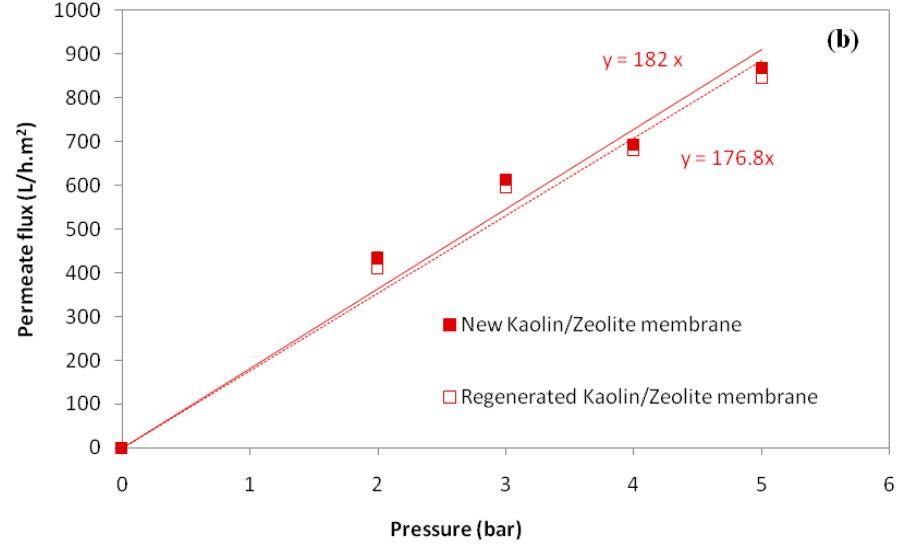
Figure 10. Water permeate flux versus transmembrane pressure for the new and regenerated membranes: kaolin/sand ( a ) and kaolin/zeolite ( b ).